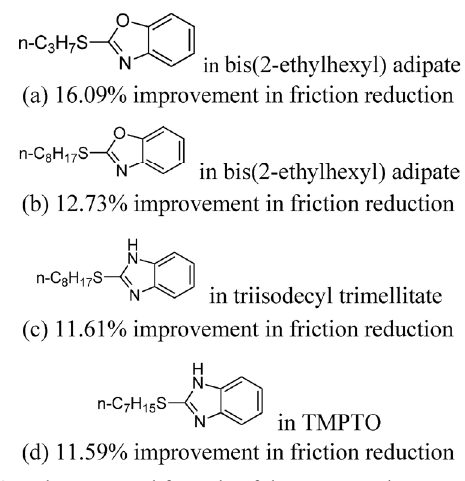
Fig. 28 The structural formula of the compound. In contrast, the friction-reduction performance of the Fig. 29 isostere in TMPTO decreased by 11.12% relative to the corresponding template molecule in the same base oil.